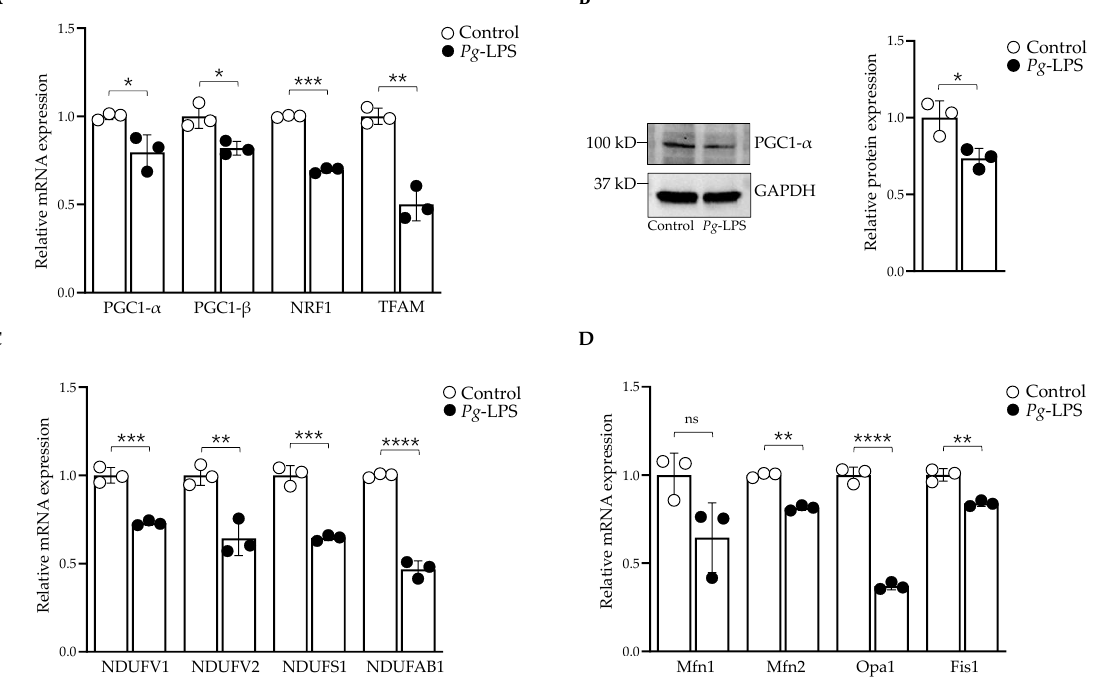
Figure 3. P. gingivalis -LPS repressed SRF and p49/STRAP. ( A ) The mRNA expression of SRF and p49/STRAP was quantified by qPCR. Western blot analysis of ( B ) SRF, and ( C ) p49/STRAP. GAPDH was used as a loading control. ( n = 3). * p < 0.05, ** p < 0.01, *** p < 0.001.